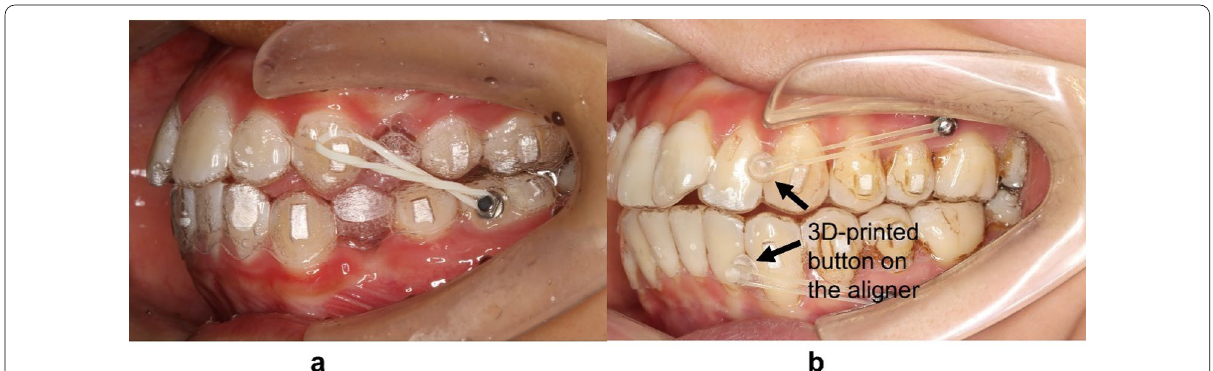
Fig. 1 a Class II elastics engaged on the mesiobuccal surface of the mandibular first molar. b The 3D-printed button on the